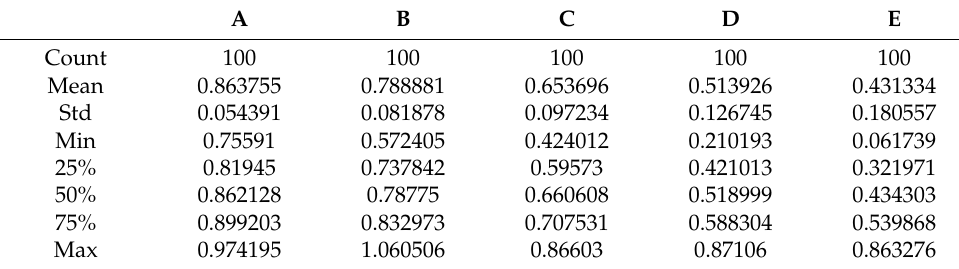
Figure 12. Measured results: distribution at points ( A – E ). In addition, based on the effectiveness measurement method, we calculated the statis- tics of relevant indicators under the three subsystems of human defence, physical defence, and technical defence, as shown in Table 9. Table 8. Statistical analysis data at five points of the proposed life